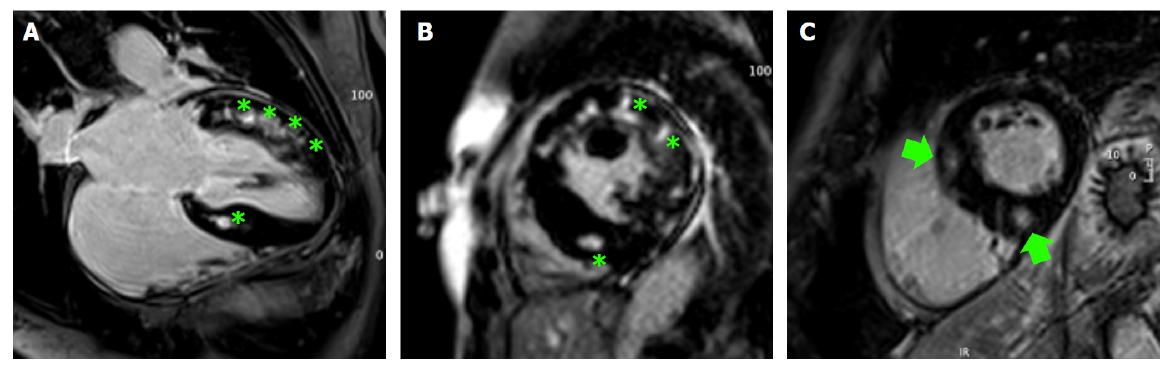
Figure 3. ( A ) and ( B ): post ‐ contrast imaging (apical 4 ‐ chambers view and mid short ‐ axis view) of a 32 ‐ year ‐ old male athlete with a diagnosis of HCM with diffuse areas of patchy non ‐ ischemic LGE (green asterisks). ( C ): short ‐ axis view post ‐ contrast imaging of a 41 ‐ year ‐ old female ex ‐ athlete with HCM showing areas of LGE in the basal anteroseptal segment and inferior RVIP (green arrows).